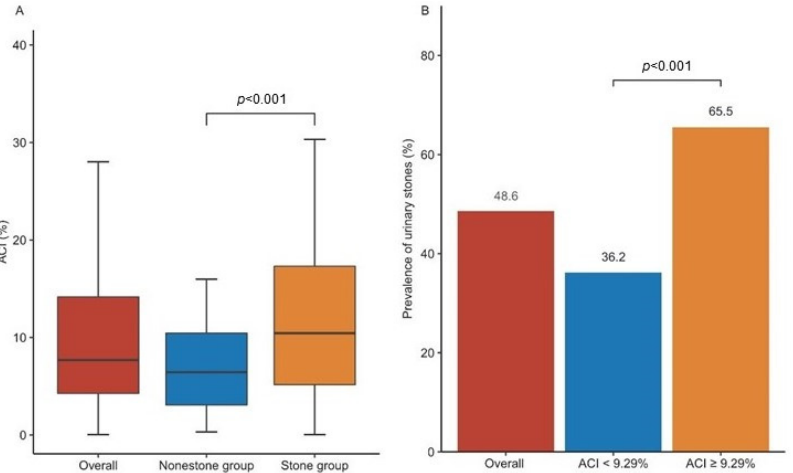
Figure 2. Association between aortic calcification index (ACI) and urinary stones. ( A ) Comparison of ACI in the non-stone group and the stone group; ( B ) The prevalence of urinary stones in patients with ACI < 9.29% and patients with ACI ≥ 9.29%.